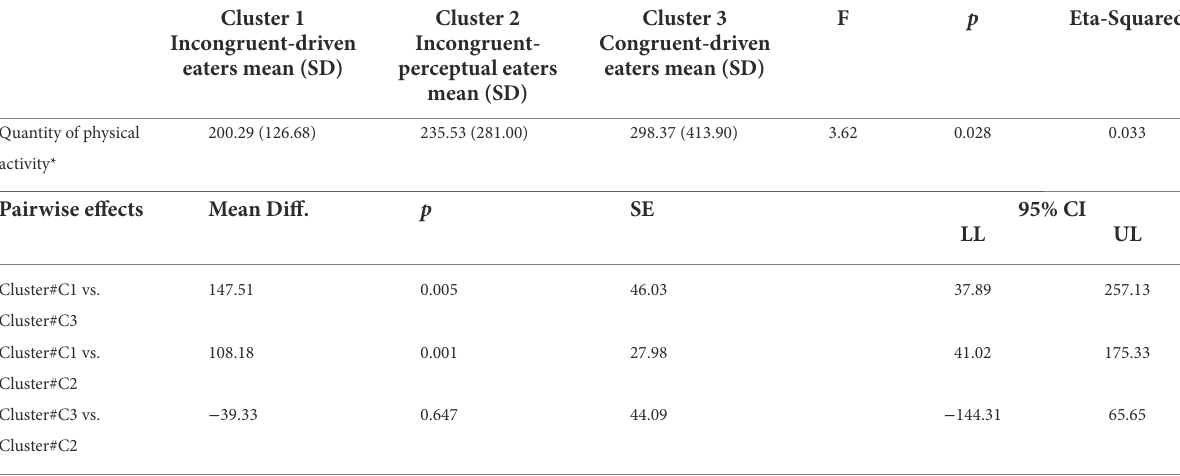
TABLE 3 Comparison of occupational-physical activity characteristics by clusters.